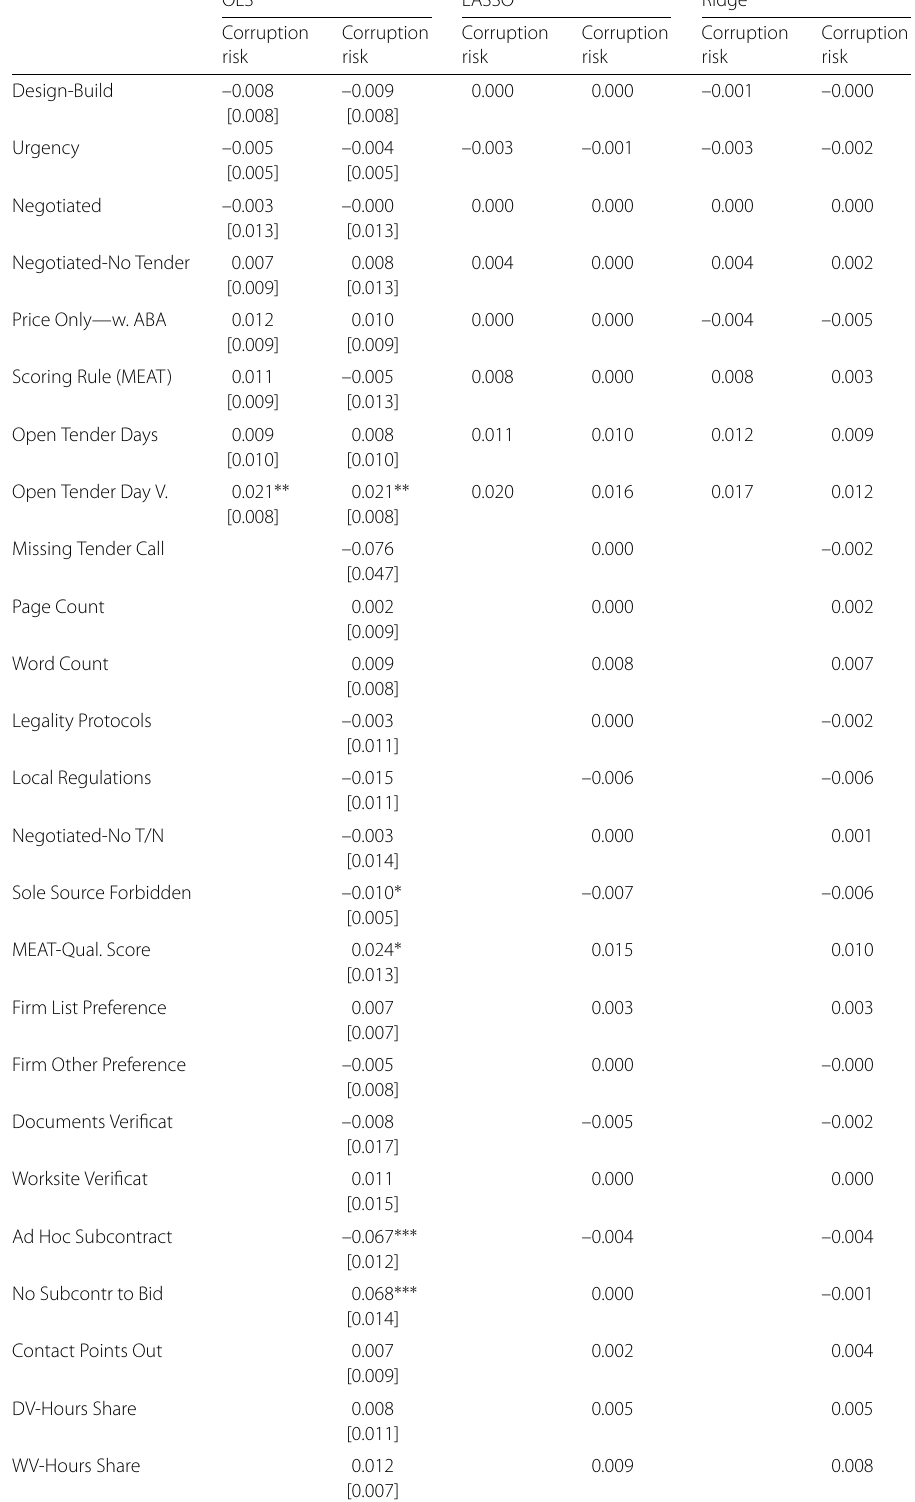
Table 7 Estimates for the small and large models—verification data